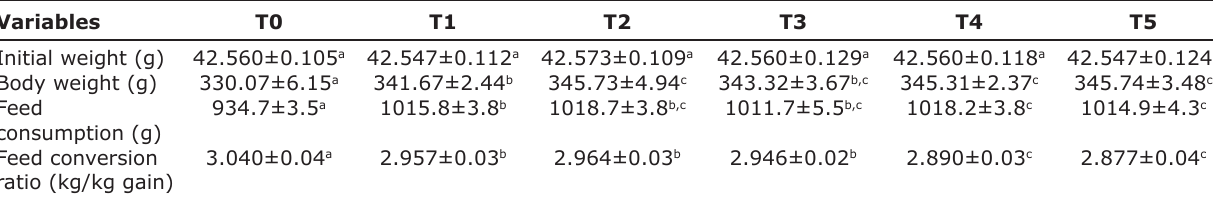
a,b,c Different superscripts in the same raw show significant difference (p<0.05). (T0) 100% basal feed, (T1) basal feed+2.5 g AGP/kg feed, (T2) basal feed+probiotic 1 mL/kg feed, (T3) basal feed+probiotics 3 mL/kg feed, (T4) basal